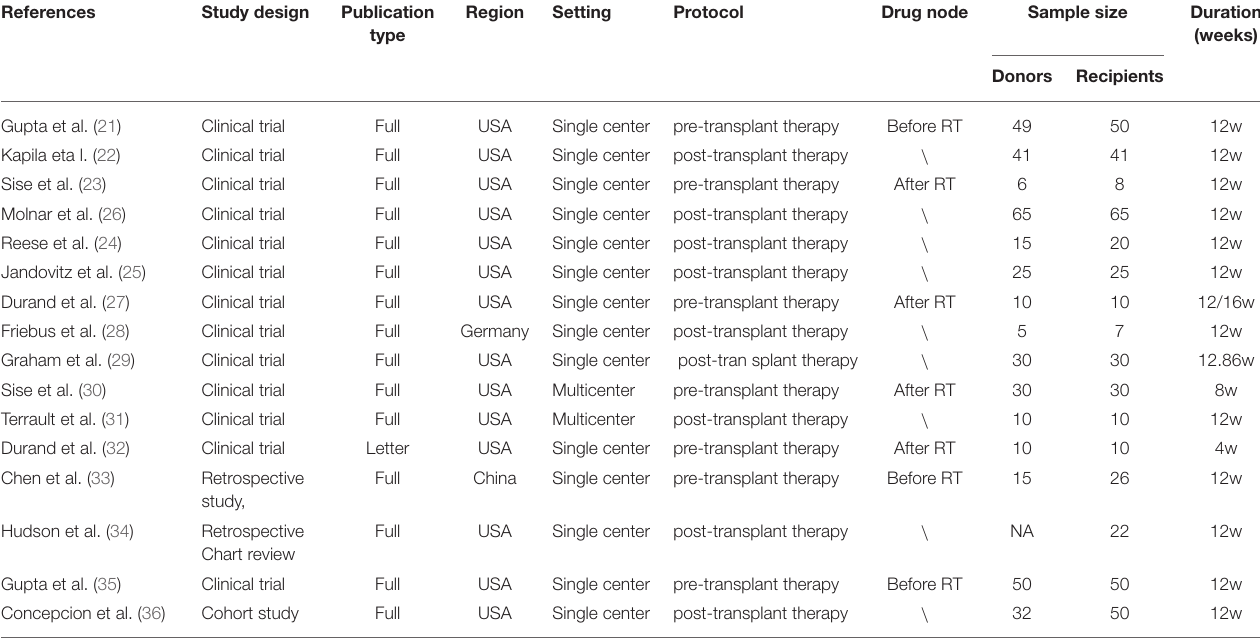
TABLE 1 | Characteristics of the studies included in this comprehensive